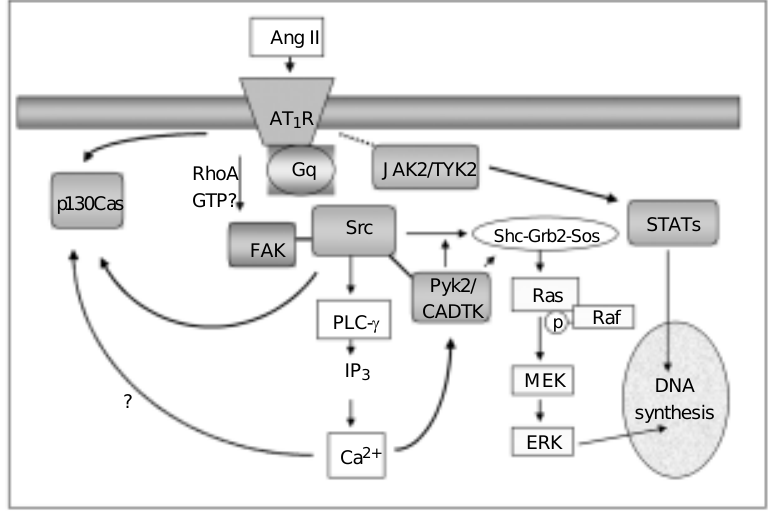
Figure 2. Tyrosine kinase pathways stimulated by angiotensin II (Ang II) in vascular smooth muscle cells. Ang II activates Src, which regulates phospholipase C- (cid:1) (PLC- (cid:1) )- and extracel- lular signal-regulated kinase (ERK)-dependent signaling pathways. Ang II binding to the angiotensin 1 receptor (AT 1 R) induces the physical association and activation of JAK2/TYK2 (Janus kinase/s) as indicated by the dashed line. JAK2/TYK2 phosphorylates STAT proteins (signal transducers and activators of transcription) that are translocated to the nucleus where they activate gene transcription. Ang II also activates focal adhesion kinase (FAK) which possesses sites favored for phosphorylation by Src. FAK associates with paxillin and talin that associate with actin. The link between AT 1 receptor and FAK is unknown, but the Rho family of GTPases are potential candidates. Pyk2 and CADTK (Ca 2+ -dependent tyrosine kinase) are activated by Ang II through Ca 2+ -dependent pathways. Activated Pyk2 regulates Src and ERK-dependent signaling cascades. p130Cas is transiently activated by Ang II, possibly via a Ca 2+ -dependent pathway. Phosphorylated p130Cas may be important in the regulation of (cid:2) -actin expression. PI3K activation by Ang II leads to Akt/protein kinase